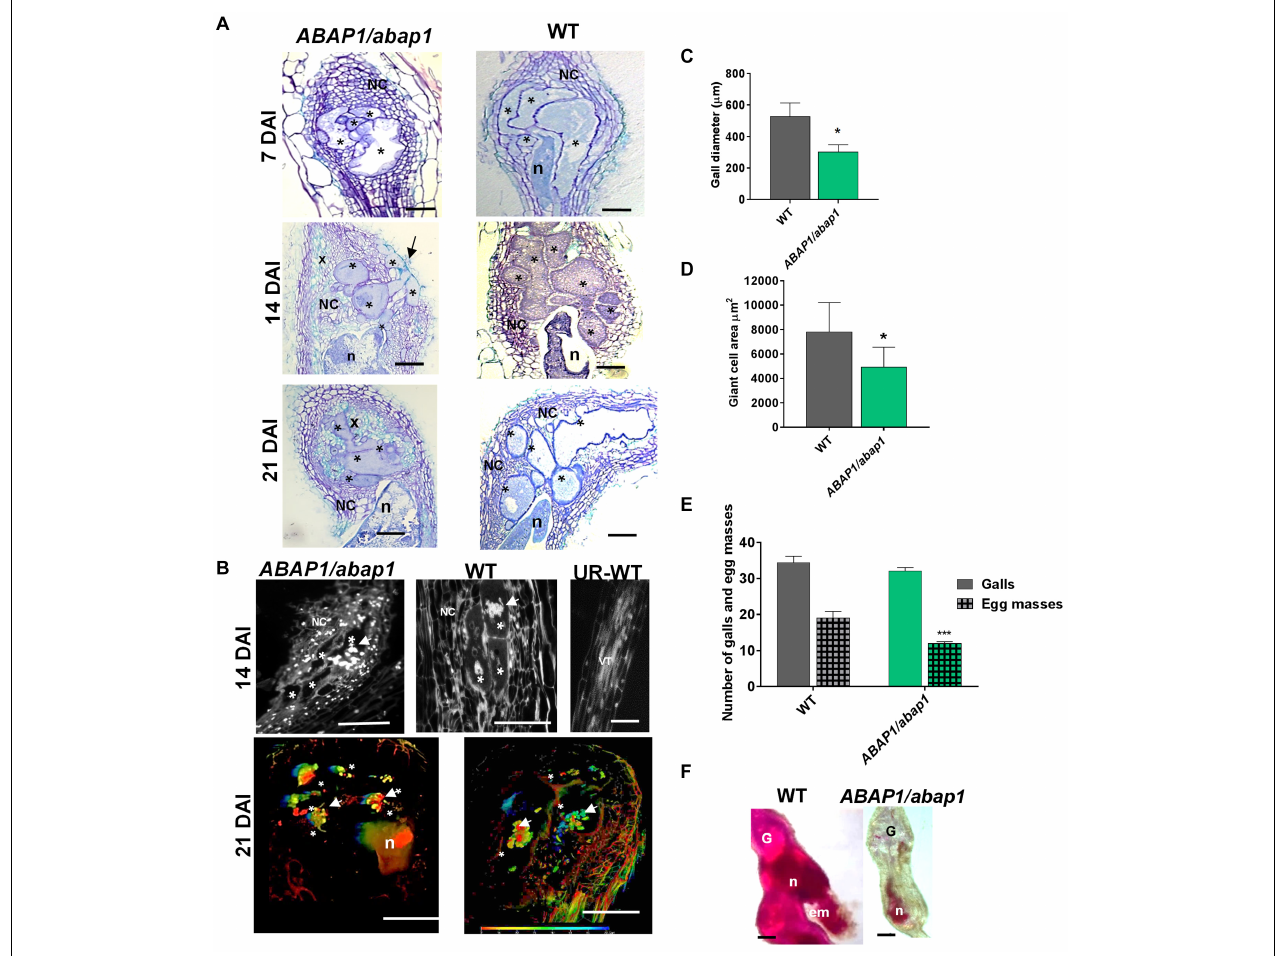
FIGURE 4 | Histological analysis and nuclei morphology of galls, and resistance tests of ABAP1 knockdown plants infected with M. incognita . (A) Bright-field images of gall sections of ABAP1/abap1 and wild-type (7, 14, and 21 DAI) stained with toluidine blue. Note abnormally convoluted giant cells extended to the gall border (arrow 14 DAI) and xylem (x) proliferation (14 and 21 DAI) upon ABAP1 knockdown. (B) Gall 21 DAI and uninfected root sections of ABAP1/abap1 and wild-type stained with 4,6-diamidino-2-phenylindole (DAPI); and 3D confocal projections of serial optical sections of wild-type (WT) and ABAP1/abap1 galls 21 DAI nuclei (white arrows), cleared and DAPI stained. Colored bars represent the depth of nuclei within the gall. DAI, days after inoculation; asterisk, giant cell. Bars = 50 µ m. (C) Gall diameter measurements revealed that ABAP1/abap1 plants have smaller galls than wild-type. (D) Giant cell measurements showed smaller giant cell area in the ABAP1 knockdown line compared to the wild-type. (E) Resistance test of ABAP1/abap1 line showed a significant reduction of eggs mass number. (F) Galls (40 DAI) from these resistance tests were acid fuchsin stained and showed a delay in nematode development under low ABAP1 levels. Statistical analysis was performed * P < 0.05) or *** P < 0.01 based on Student’s t -est. Asterisk, giant cell; NC, neighboring cells; n, nematode; x, xylem; G, gall; em, egg mass. Scale bars = 50 µ